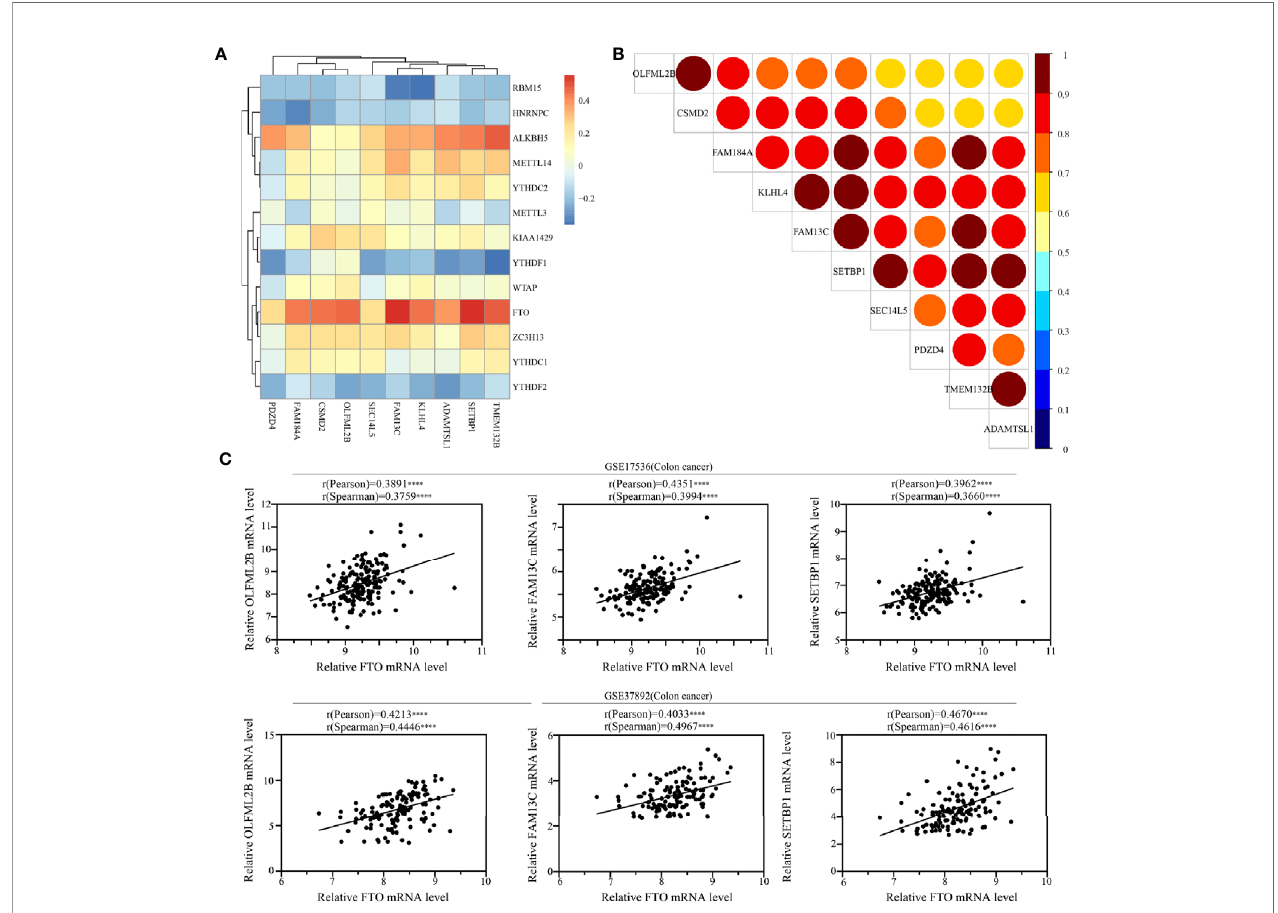
FIGURE 8 | Correlation between the survival-associated genes and the m 6 A RNA modi fi cation regulators. (A) Correlations between m 6 A regulators and the survival- associated genes in READ cohort using Spearman analysis. (B) Correlations between the survival-associated genes in READ cohort using Spearman analysis. (C) Correlations between FTO and the survival-associated genes OLFML2B, FAM13C, and SETBP1 in Gene Expression Omnibus (GEO) data sets using Spearman analysis (**** P <